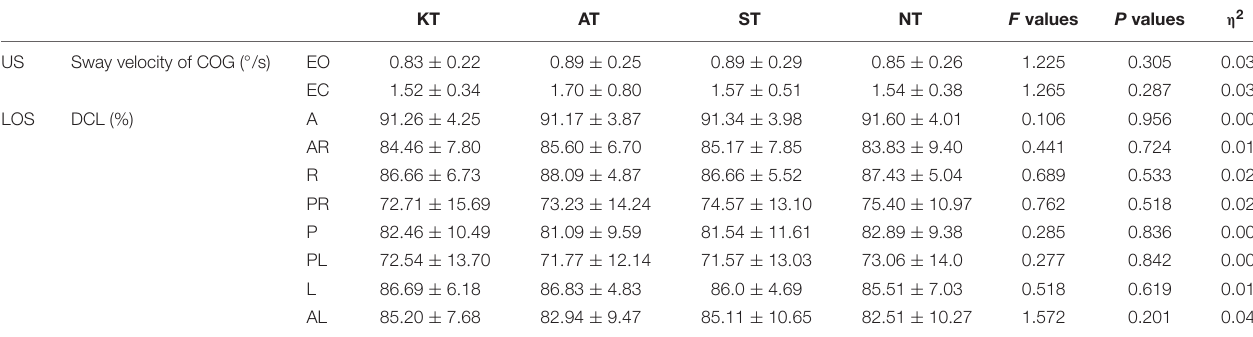
TABLE 3 | Comparison of parameters in US and LOS for different taping treatments ( ¯ x ± s ). KT AT ST NT F values P values η 2